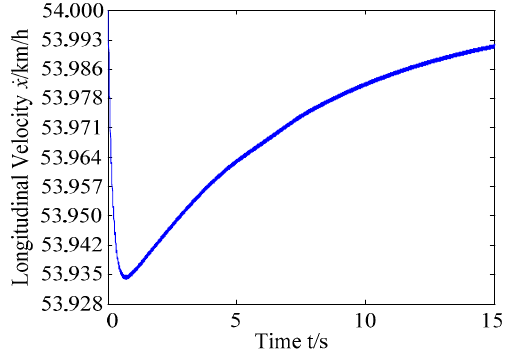
Figure 14. Trajectories with the actual trajectory and the predicted trajectory of the obstacle.